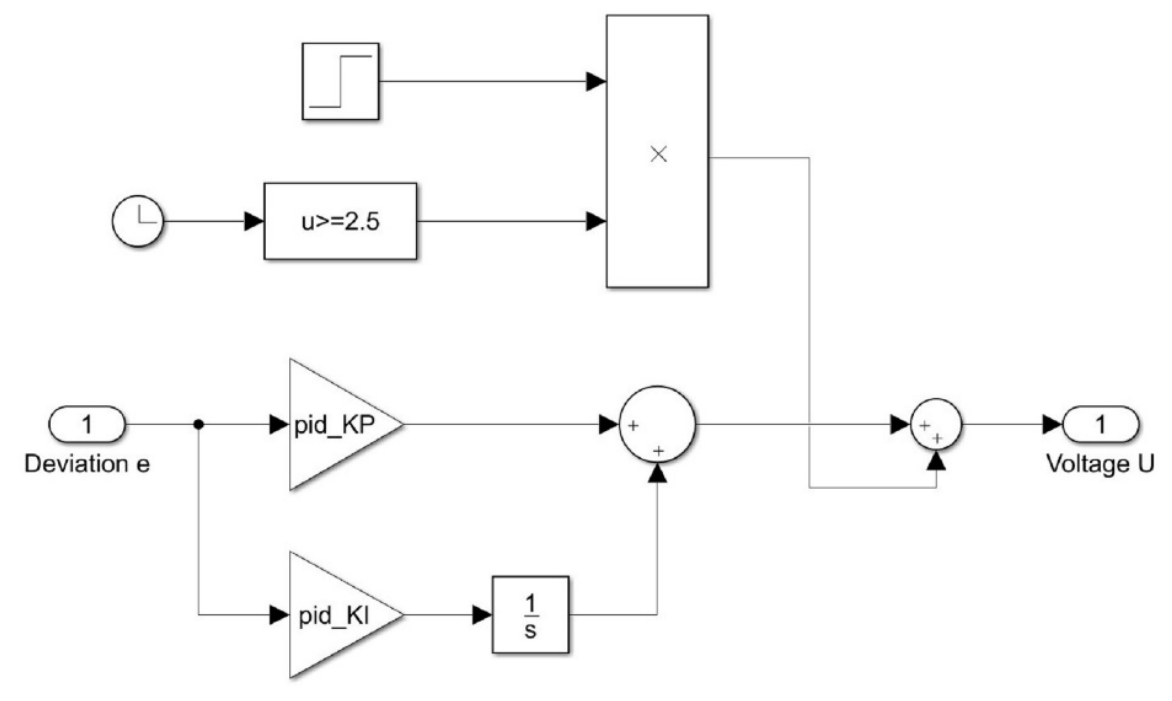
Figure 9. PID control strategy Simulink model.